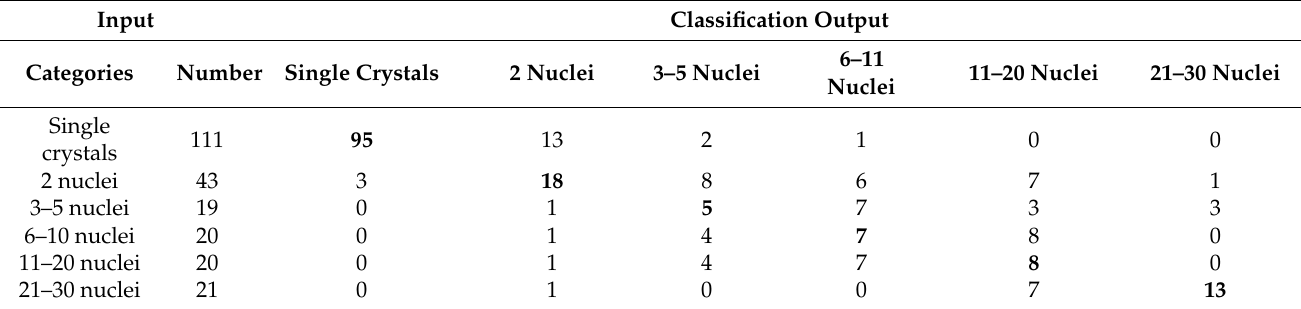
Table 1. Classification of the particles into different categories according to the proposed